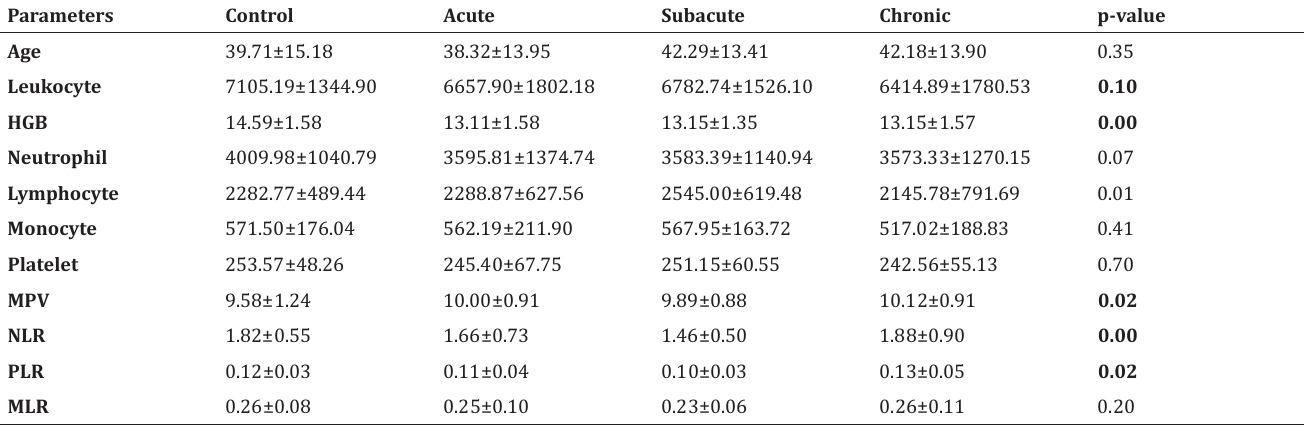
Evaluation of hematological parameters according to the control group and brucellosis subgroups Parameters